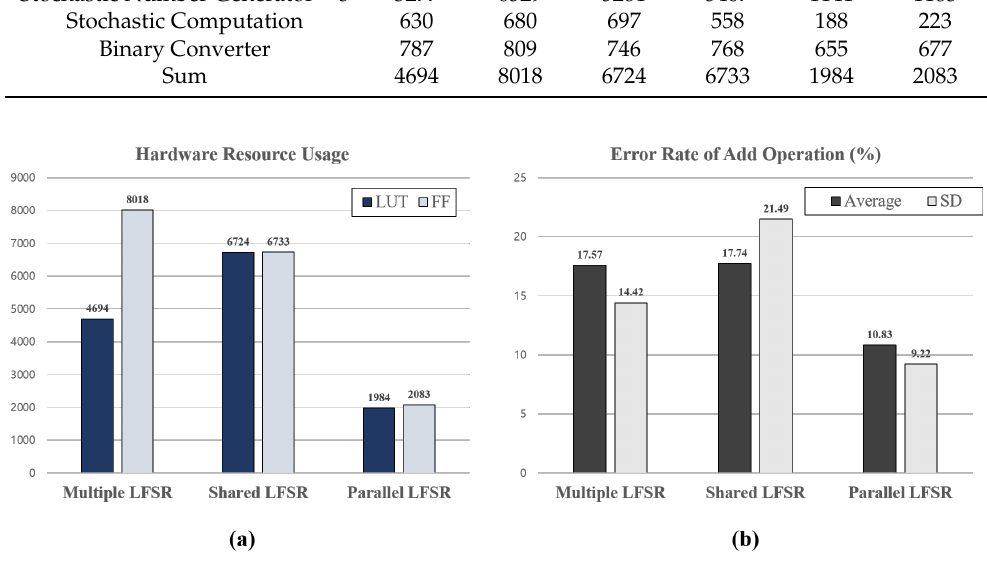
Figure 18. ( a ) Hardware resource usage applying three different LFSRs in SC ( b ) Error rate in addition applying three different LFSRs.